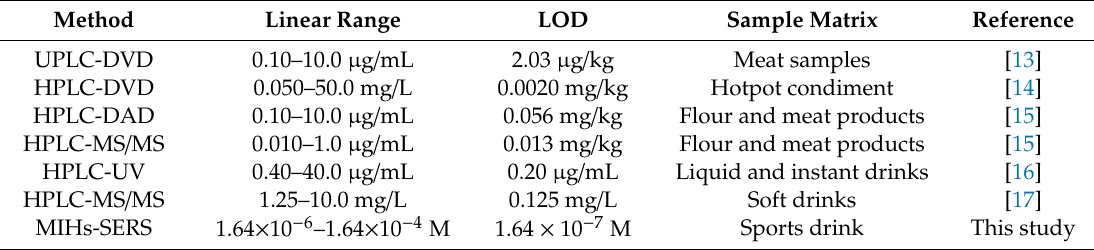
Table3. Comparisonofdi ff